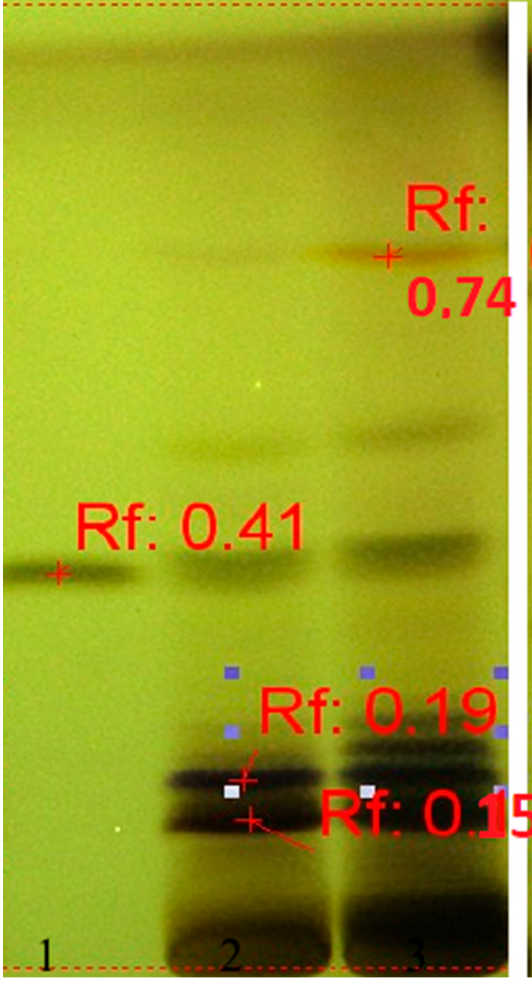
Figure 2. HPTLC fingerprint of ecdysones in Helleborus samples. Track 1: reference substance β -ecdysone, Rf ≈ 0.41; track 2: H1; track 3: H2.